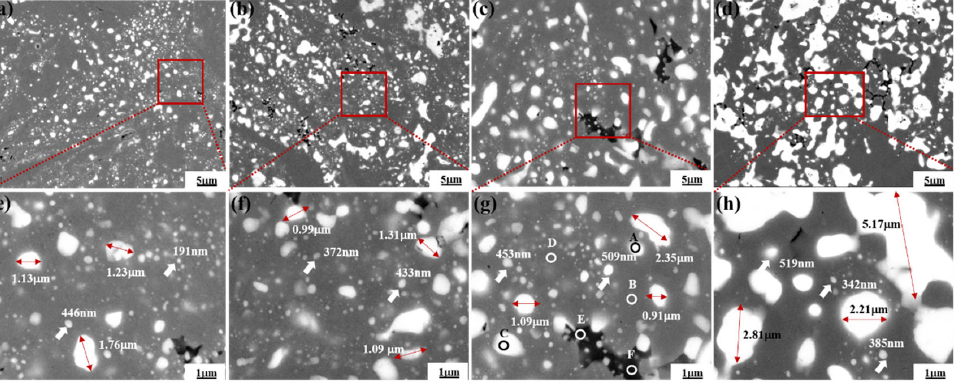
Figure 4. SEM images of the composites with different Eu 2 O 3 mass percentages: ( a , e ) HP5; ( b , f ) HP10; ( c,g ) HP15; ( d , h ) HP20. Table 2. Chemical composition (wt.%) at each point in HP15 composite.